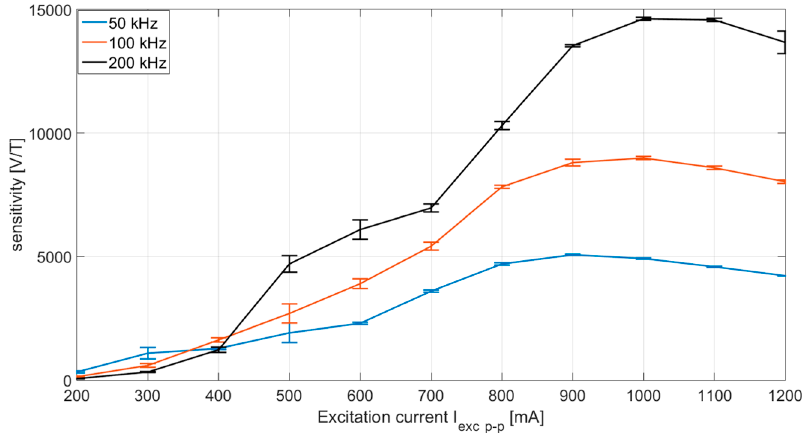
Figure 4. Sensor sensitivity as a function of excitation current for three different